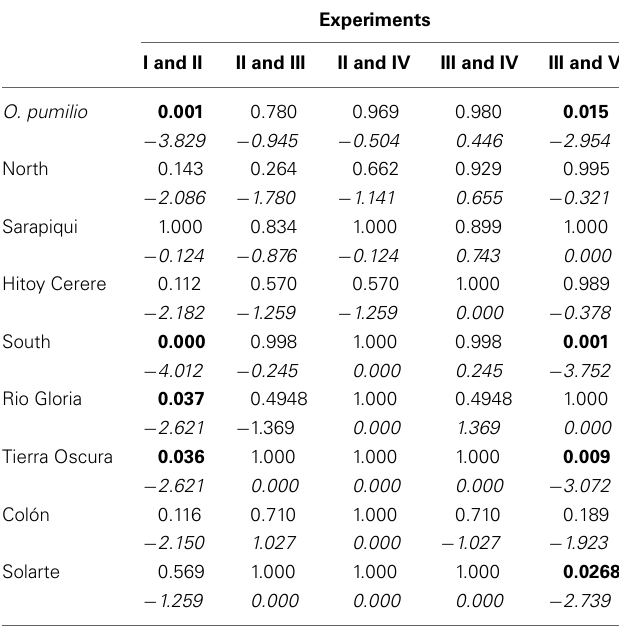
Table 2 | Results ( P -values) of pairwise comparisons among different experiments including test statistics ( z -values) in